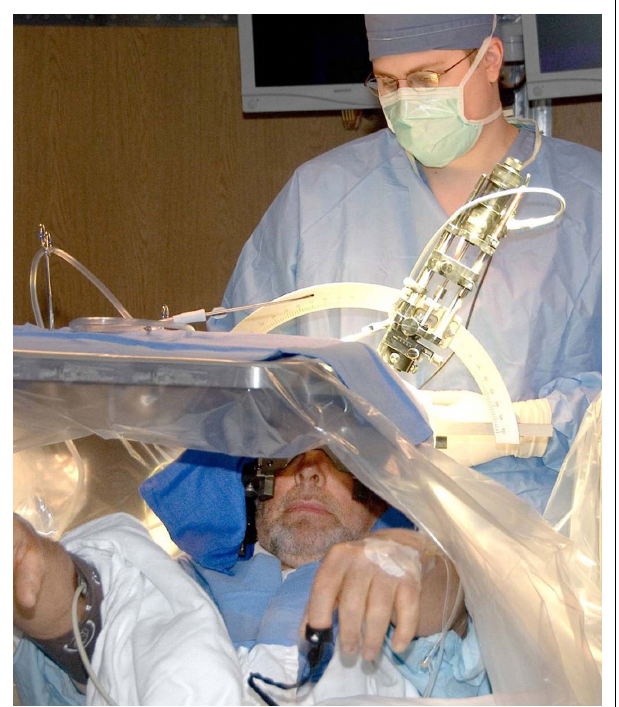
FIGURE 2 | Intraoperative photo of a patient undergoing DBS surgery for Parkinson’s disease. As can be seen in the picture, patients are typically kept awake during the surgery to clinically assess the efficacy of electrode placement with real time stimulation, as well as any unwanted side effects. If the location is deemed suboptimal, it can easily be changed intraoperatively and reassessed.